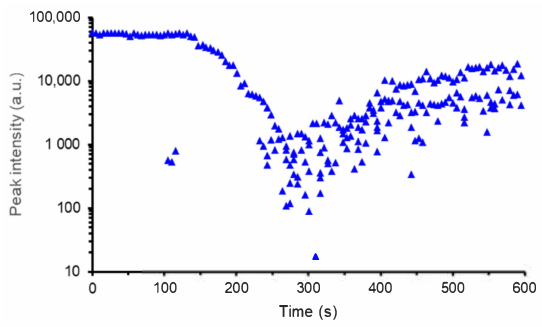
Figure 9. Regeneration of FBG using CO 2 laser annealing. Annealing parameters: scan movement: sinus + gating signal, f SCAN = 100 Hz, DX SCAN = 14 mm, PWM < 40%, f CO